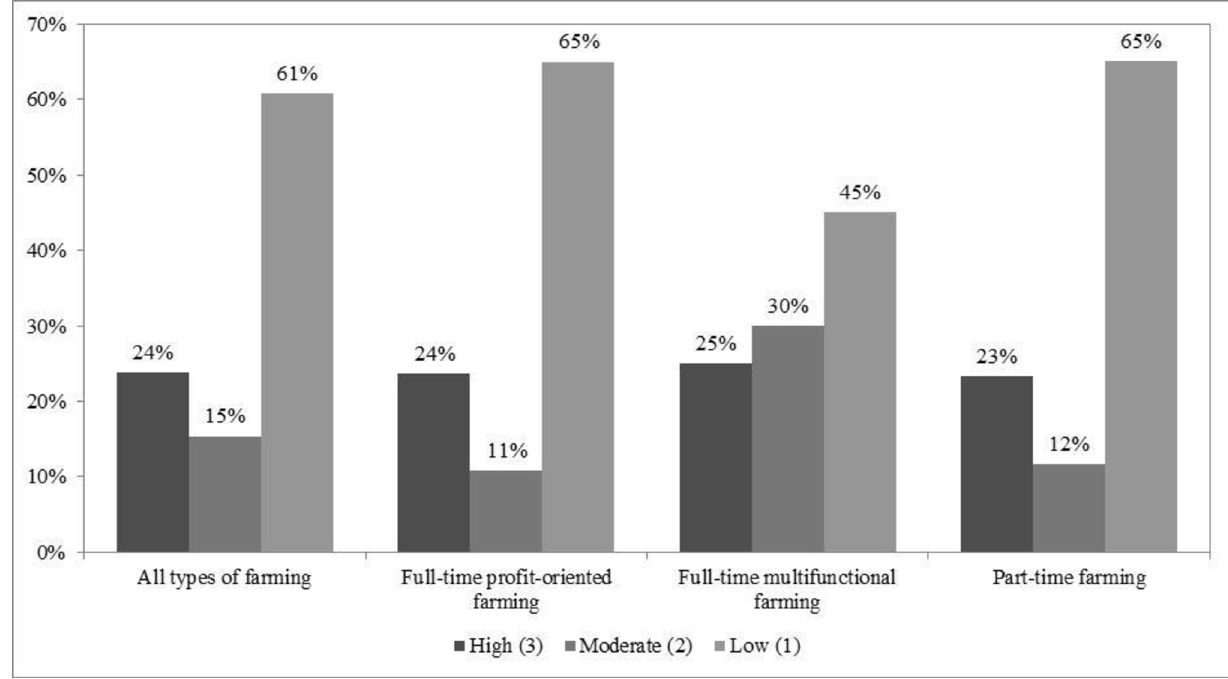
Fig 4. Net farming income per rai. Note: 1) n = 176 and 2) Kruskal-Wallis H test ( χ 2 ) = 3.17, insignificant at any level.